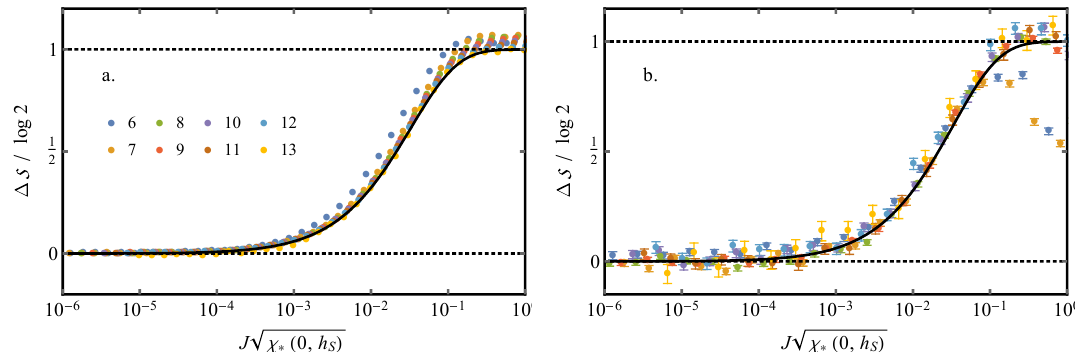
Figure 12: Entropic enhancement of the bath : two numerical measures of the en- tropic enhancement of the bath (coloured points, L values inset) are compared with the theoretical prediction (114) (solid black). Left panel: we extract ∆ S as defined by (111b). Right panel: we extract ∆ S as defined by (111a) with χ (cid:63) extracted us- ing (119). For very small sizes (right panel L = 6,7) there is significant disagreement once the coupling J becomes large. Number of realisations per data point: in the left panel N = 10,1000,2000 and N = 6000 for L = 13,12,11 and L ≤ 10 respectively; in the right panel N = 100,1000,3000,10 4 , and N = 10 5 for L = 13,12,11,10 and L ≤ 9